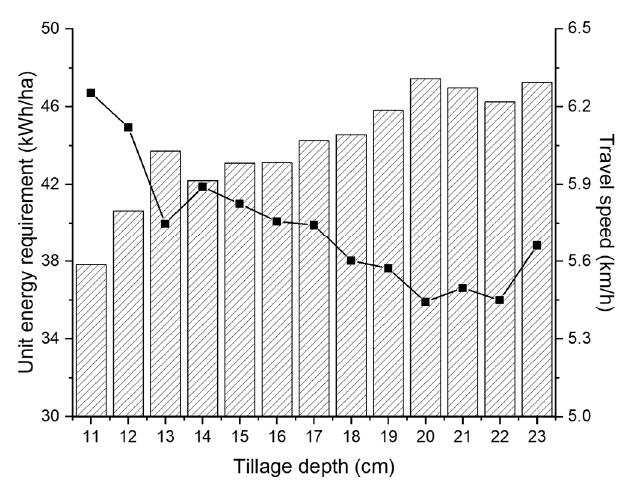
Figure 15. Unit energy requirement of agricultural tractor according to tillage depth.